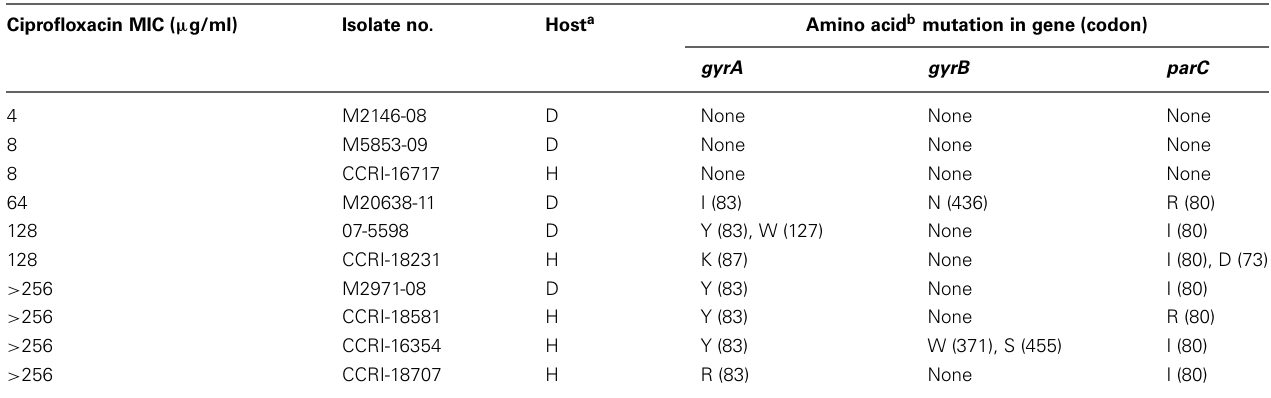
Table 4 | Mutations in gyrA/B and parC of clinical E. faecium isolates with their corresponding ciprofloxacin MIC. Ciprofloxacin MIC ( µ g/ml) Isolate